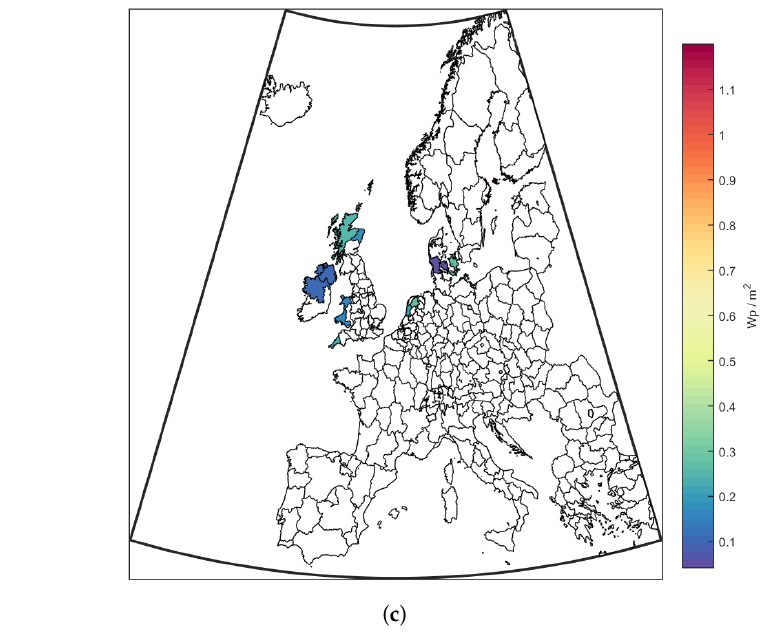
Figure 9. Model results for the lower allowed wind density scenario including ( a ) the electricity generated by generation type and year plus yearly electricity transmitted internationally and yearly energy transferred to storage, ( b ) the installed capacity density of onshore wind power, and ( c ) the installed capacity density of offshore wind power represented in terms of capacity per land area of the region it is connected to. Note that the order of the legends for line and area plots corresponds to the order of the respective values in 2010 from top to bottom. Note also that the color of the regions/quadrants on map plots indicates the installed capacity density in the given region/quadrant where white signifies zero